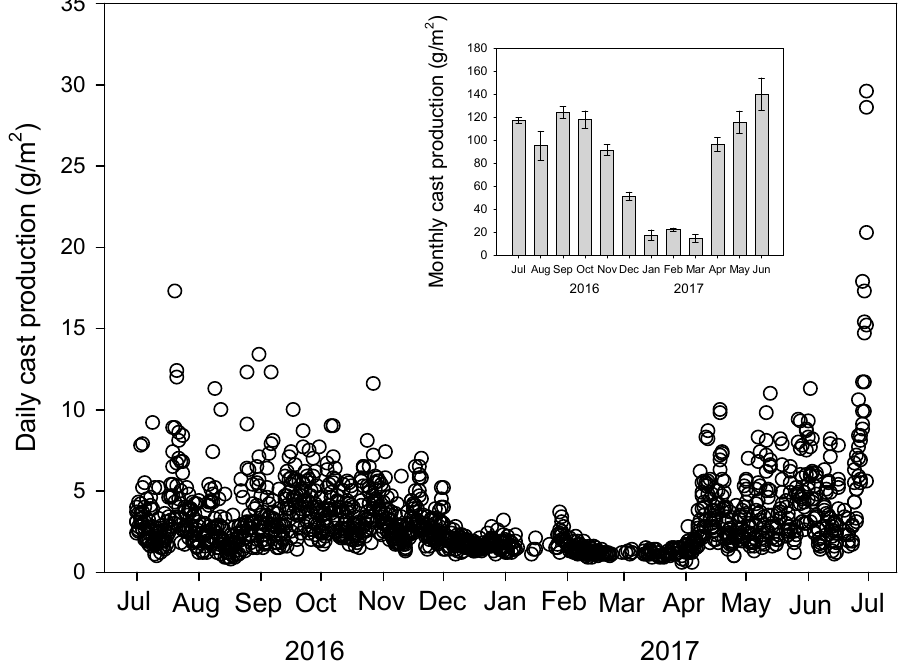
Figure 1. Daily earthworm cast production (dry weight) and monthly earthworm cast production (dry weight, means ± SE, n = 5) during July 2016 to July 2017 in the studied subtropical plantation.